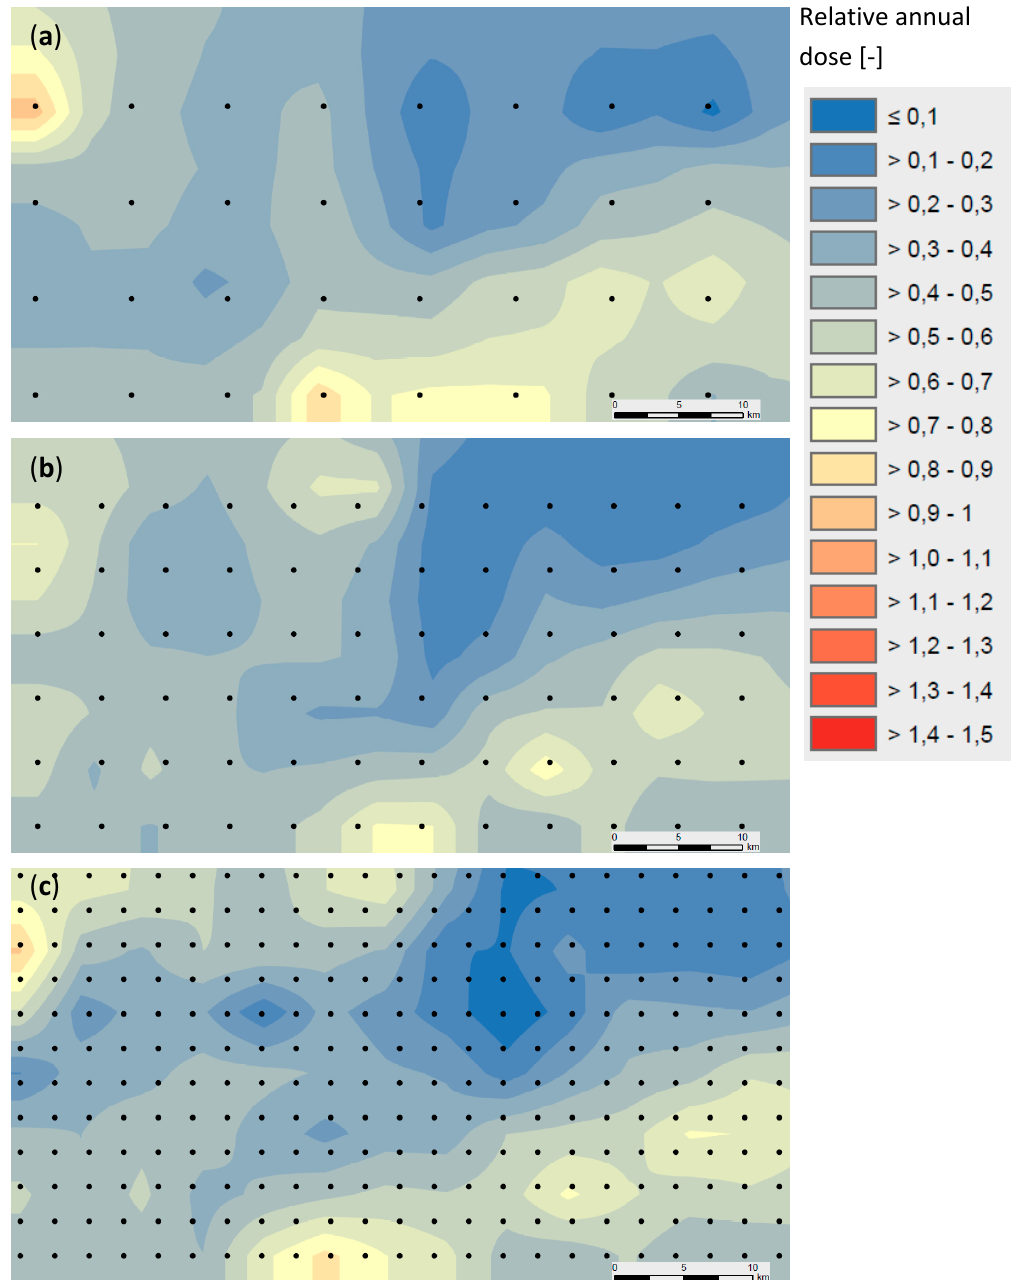
Figure 6. Relative annual dose in Lötschental based on exposure model EM 2 and the logistic decay model LM at different resolutions, reference location: Uppsala, Sweden. ( a ): 7.5 × 7.5 km, ( b ): 5.0 × 5.0 km, ( c ): 2.5 × 2.5 km.